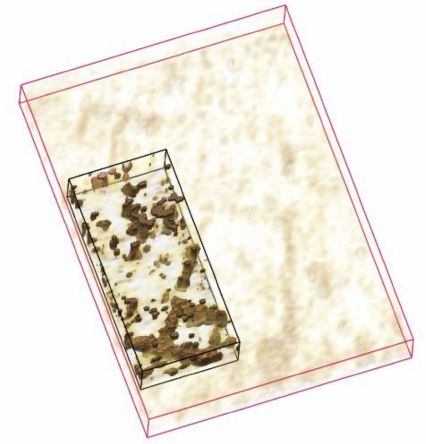
Figure 9. 3D image of the reflecting objects that correspond to